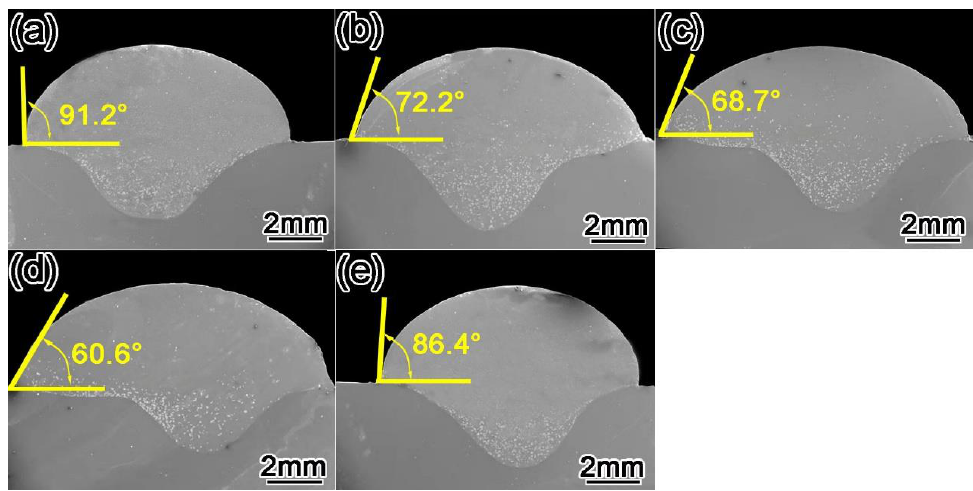
Figure 6. Cross-sectional morphology of surfacing layer with different content of Y 2 O 3 ( a ) 0 wt.%, ( b ) 0.4 wt.%, ( c ) 0.8 wt.%, ( d ) 1.2 wt.%, and ( e ) 1.6 wt.%. Wetting refers to the process in which one fluid on the surface of the solid is replaced by another fluid. As shown in Figure 7, basic wetting can be expressed by the young Dupre equation as follows [34]. The smaller the wetting angle θ, the better the wettability. Wettability depends on the surface tension of solid σ sg , solid –liquid interfacial tension σ sl , and liquid surface ten- sion σ lg with respect to the magnitude of these three forces. For liquids, the lower the sur- face tension, the better the wettability [35,36]. The reason is that Y 2 O 3 is added to the de- posited metal as an oxide dispersed particle. The conductivity and thermal conductivity of the deposited metal decrease with the increase in Y 2 O 3 content so as to reduce the sur- face tension of the molten pool metal and reduce the wetting angle, indicating that Figure 7. Schematic diagram of wetting.